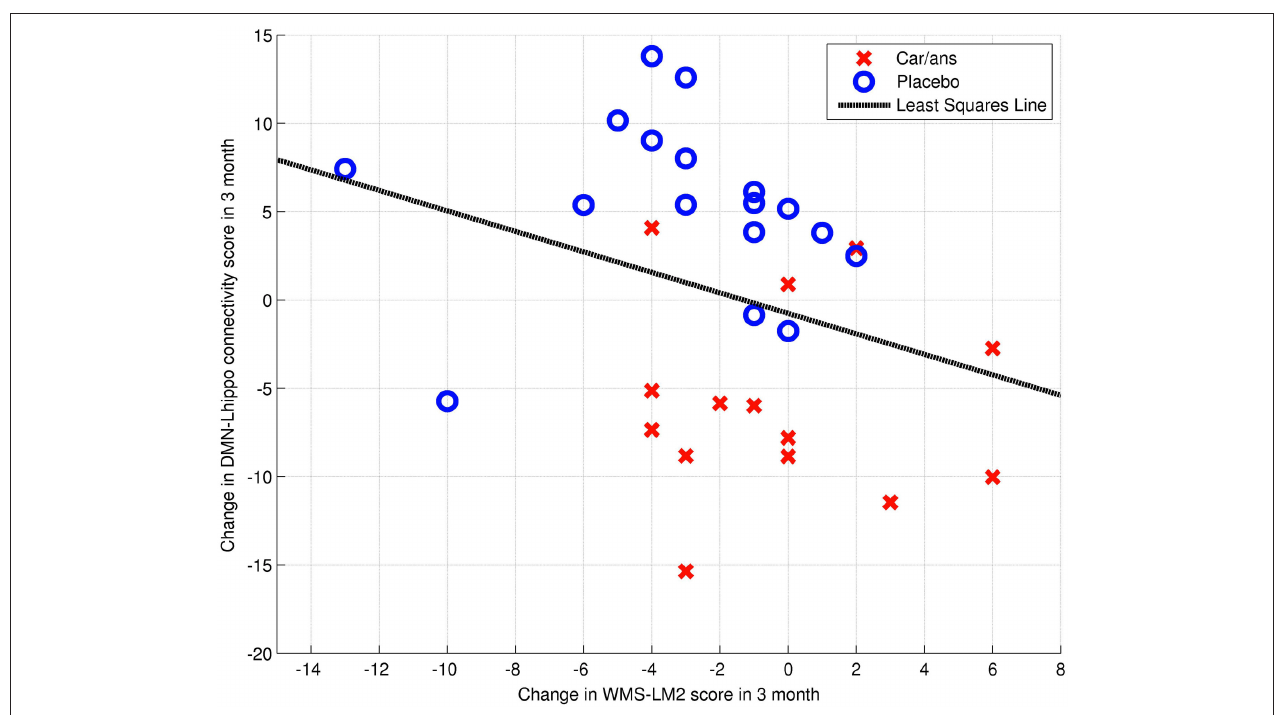
FIGURE 6 | Dependency between change in WMS-LM2 score and change in connectivity between DMN and Left hippocamus/WM voxel (MNI coordinates: x = − 18 , y = − 34 , z = − 8 ; Spearman’s r = 0.446 , p = 0.043 ). Carnosine/anserine (car/ans) subjects are presented with red crosses and placebo subjects with blue